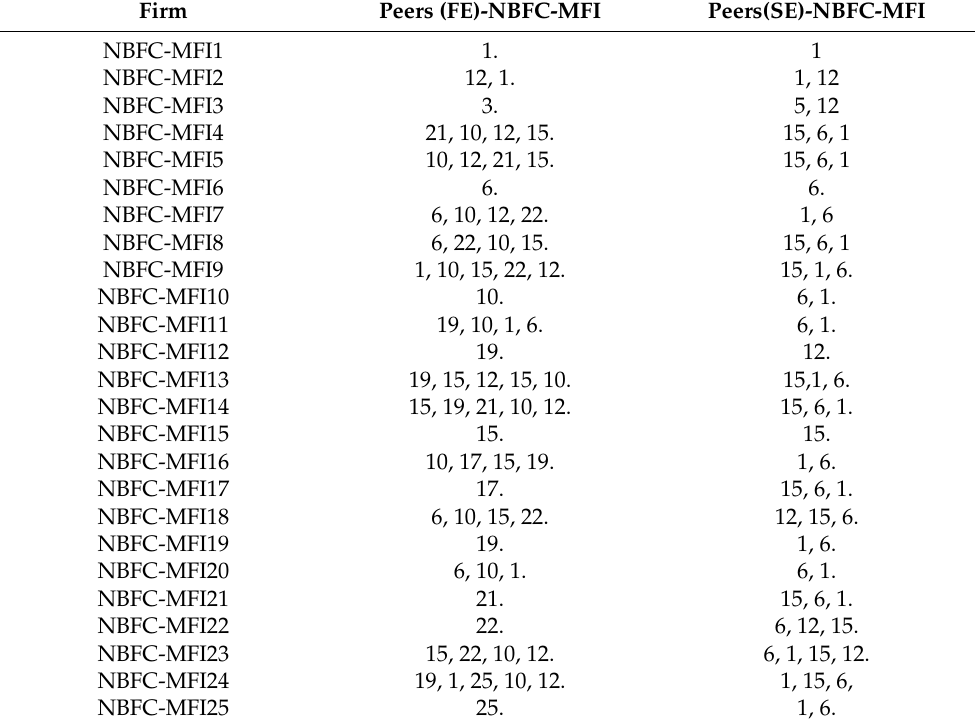
Table 7. Peer Summary.